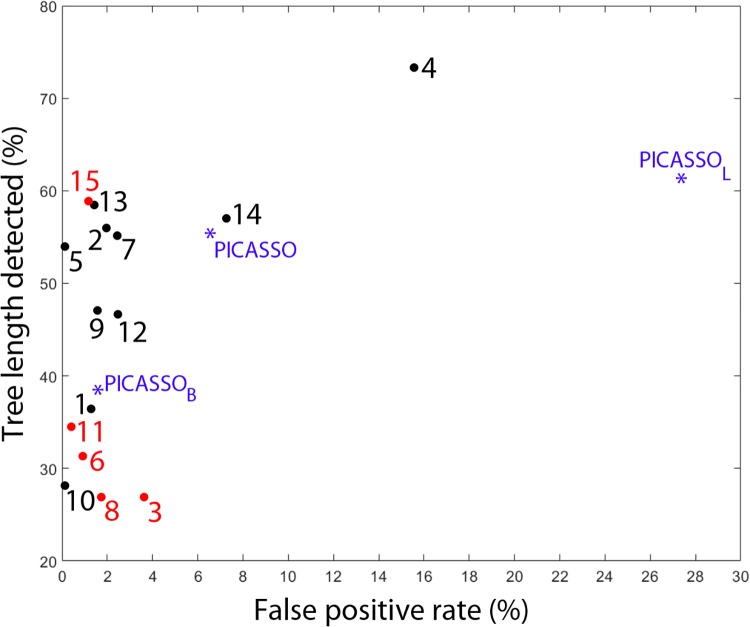
EXACT09: False positive rate vs tree length detected.The 15 bullets are results represented in [17] after the 15 algorithms originally tested, while the 3 asterisks are relevant to the 3 versions of the proposed PICASSO algorithm, which are newly inserted for a comparison.